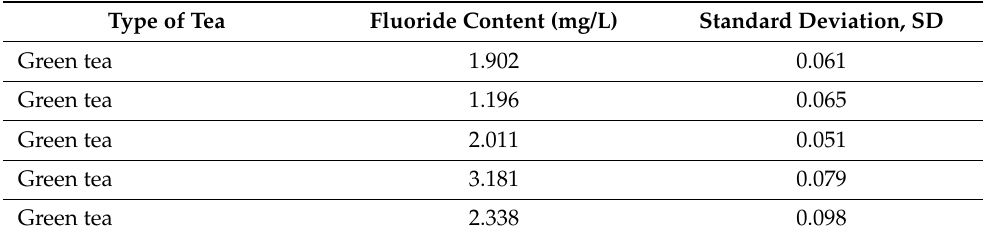
Table 2. Content of fluoride (mg/L) in infusions of selected teas. Type of Tea Fluoride Content Type of Tea